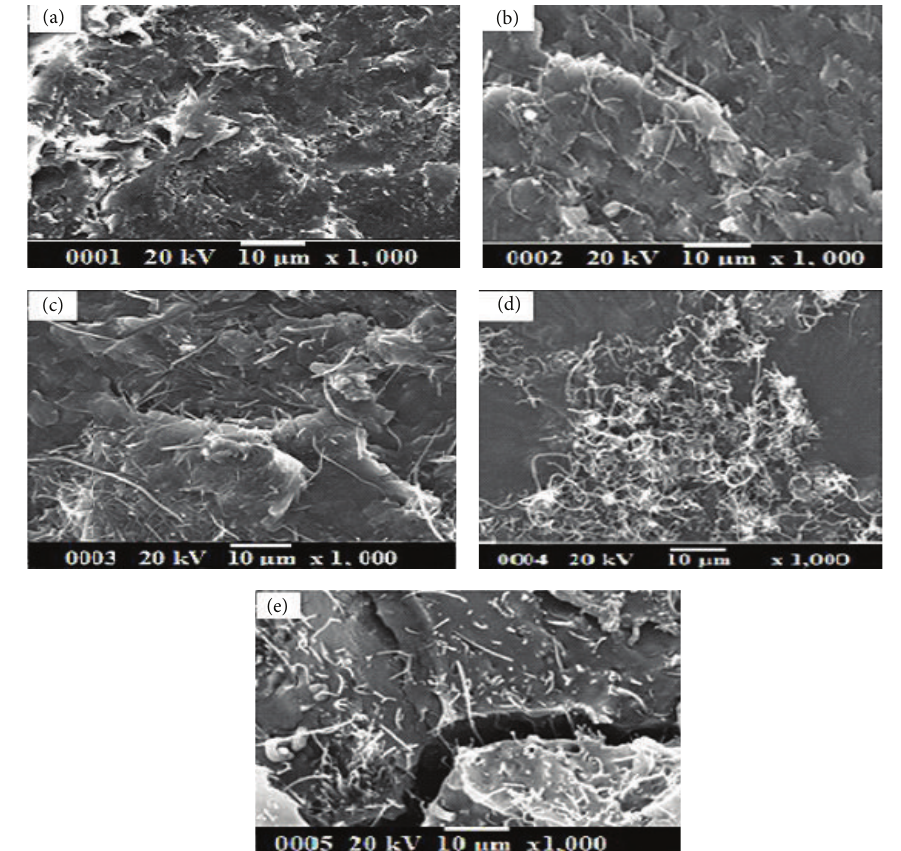
Figure 5: SEM of (a) 0wt.%, (b) 1wt.%, (c) 5 wt.%, (d) and (e) 7wt.% nanocomposites.